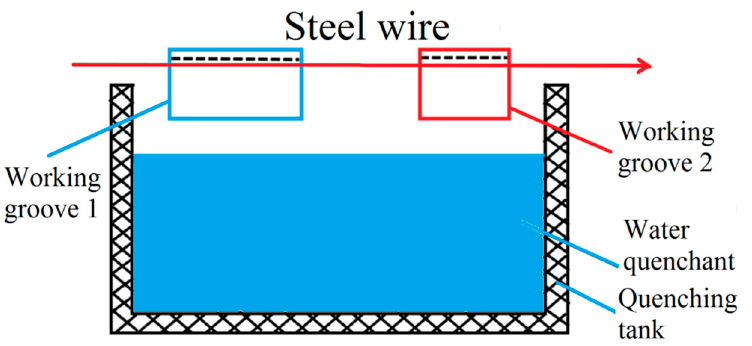
Figure 14. Schematic diagram of the water bath quenching of steel wire. Reprinted with permission from ref. [22].